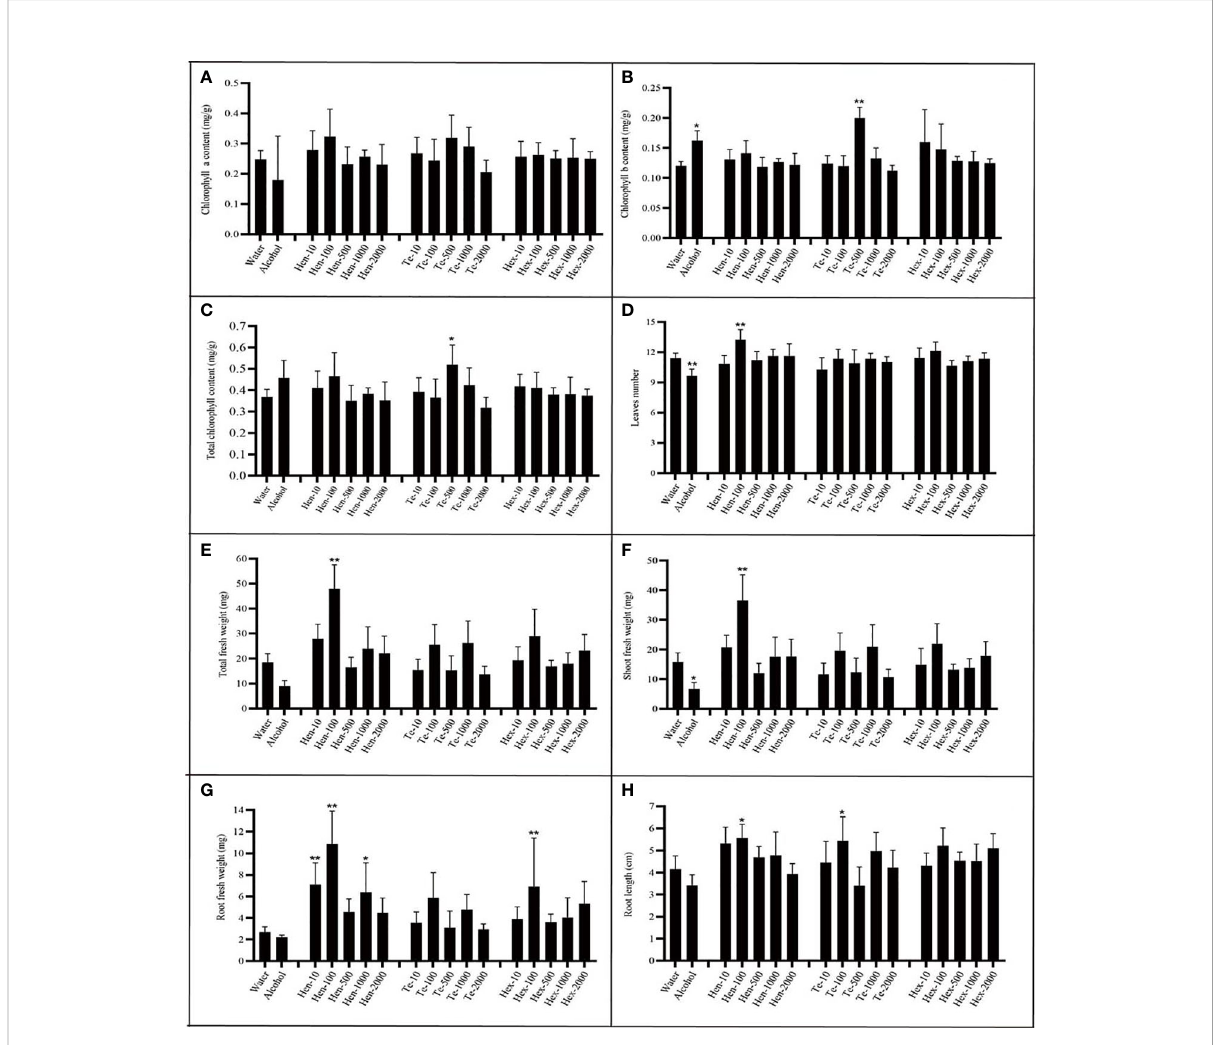
FIGURE 7 Effect of varying chemical concentrations on growth parameters. (A) chlorophyll a content; (B) chlorophyll b content; (C) total chlorophyll content; (D) leaf numbers; (E) total plant fresh weight; (F) shoot fresh weight; (G) root fresh weight; (H) largest root length. ‘ Hen ’ indicates hendecane; “ Te ” indicates tetradecane; ‘ Hex ’ indicates 1-hexanol; n=7; The number behind ‘ - ’ means the dose added (µg per plate). ‘ * ’ indicates P< 0.05, compared with water control using Dunnett ’ s test; ‘ ** ’ indicates P< 0.01, compared with water control using Dunnett ’ s test. Standard error indicated in error